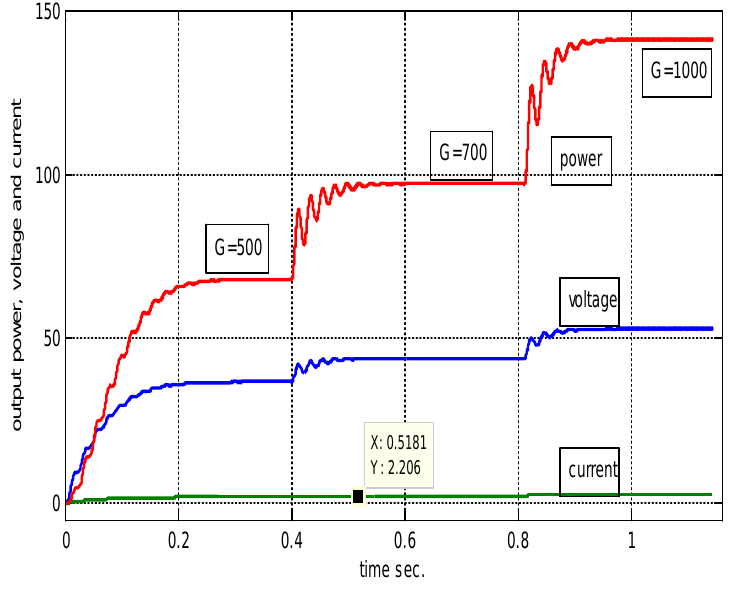
Figure 11. The boost converter output responses at T = 30 °C. Table 3. The output power, voltage, and current at variable values of sun irradiance.